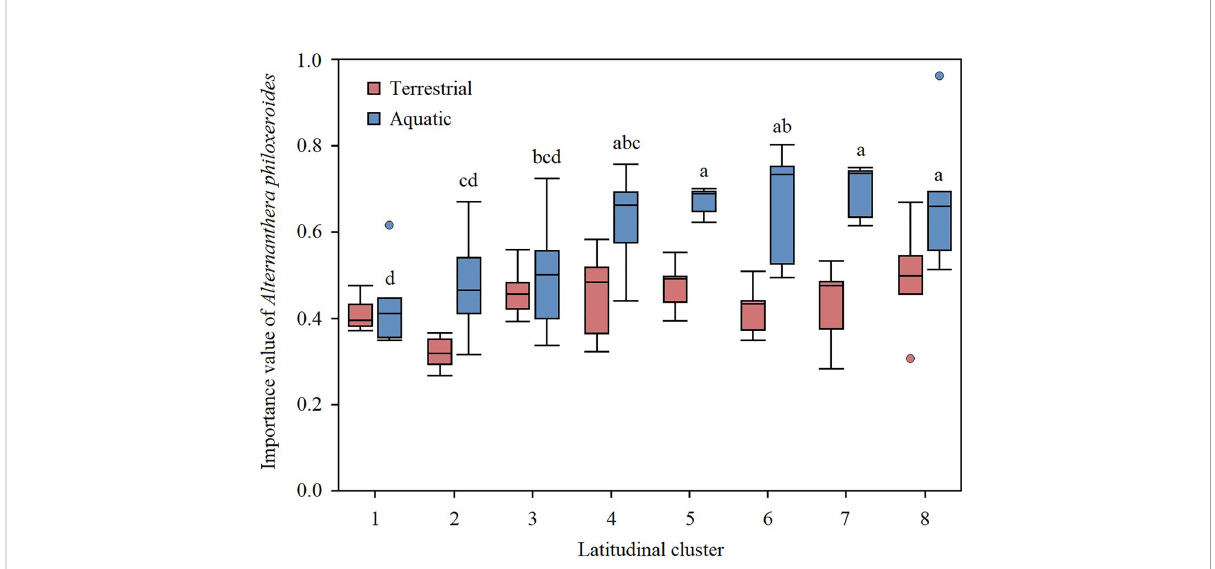
FIGURE 2 Variations in A . philoxeroides dominance in terrestrial and aquatic habitats among different latitudinal transects. The upper and lower bounds of the box represent the 75% and 25% percentiles, respectively; the line in the middle represents the mean and the whiskers extended to the 5% and 95% percentiles, respectively. Solid dots represent the outliers. The different letters indicate that the importance value has signi fi cant differences at the 0.05 level.